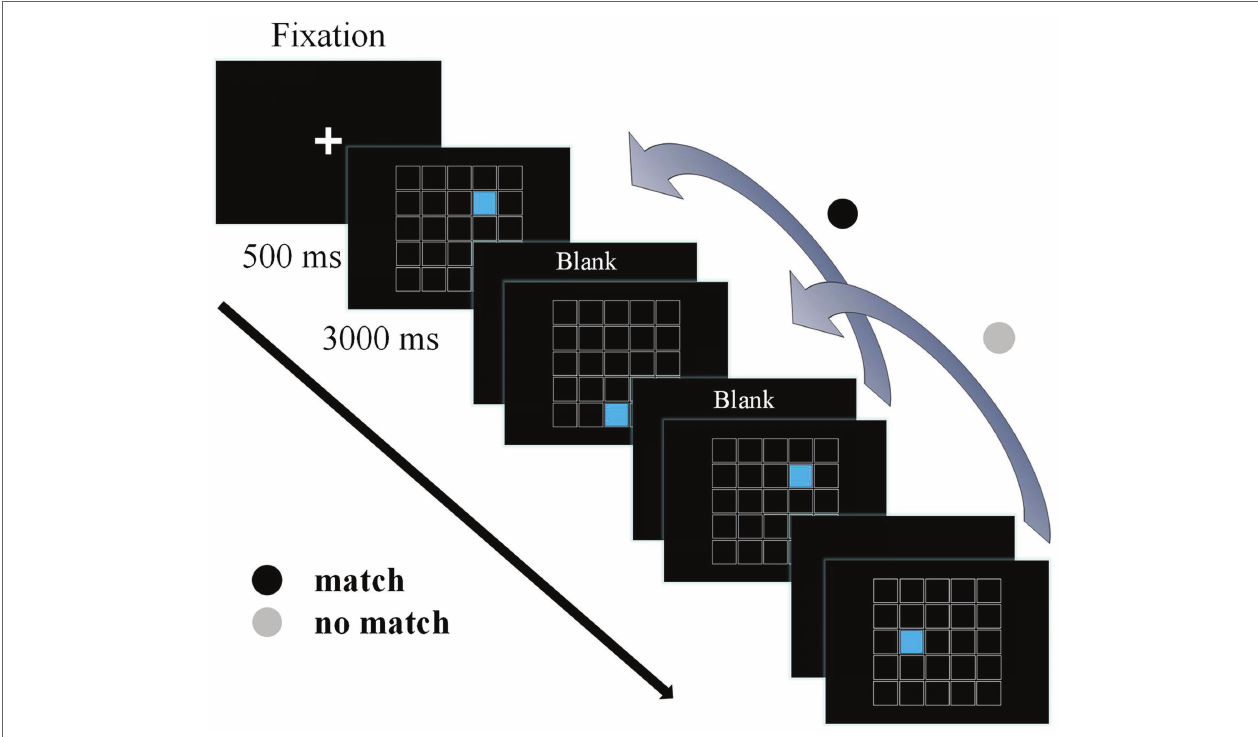
FIGURE 1 | The spatial 2-back task. A fixation point was presented before stimulus onset, followed by a 500 ms stimulus and a 3,000 ms reaction time, for a total stimulus time window of 3,500